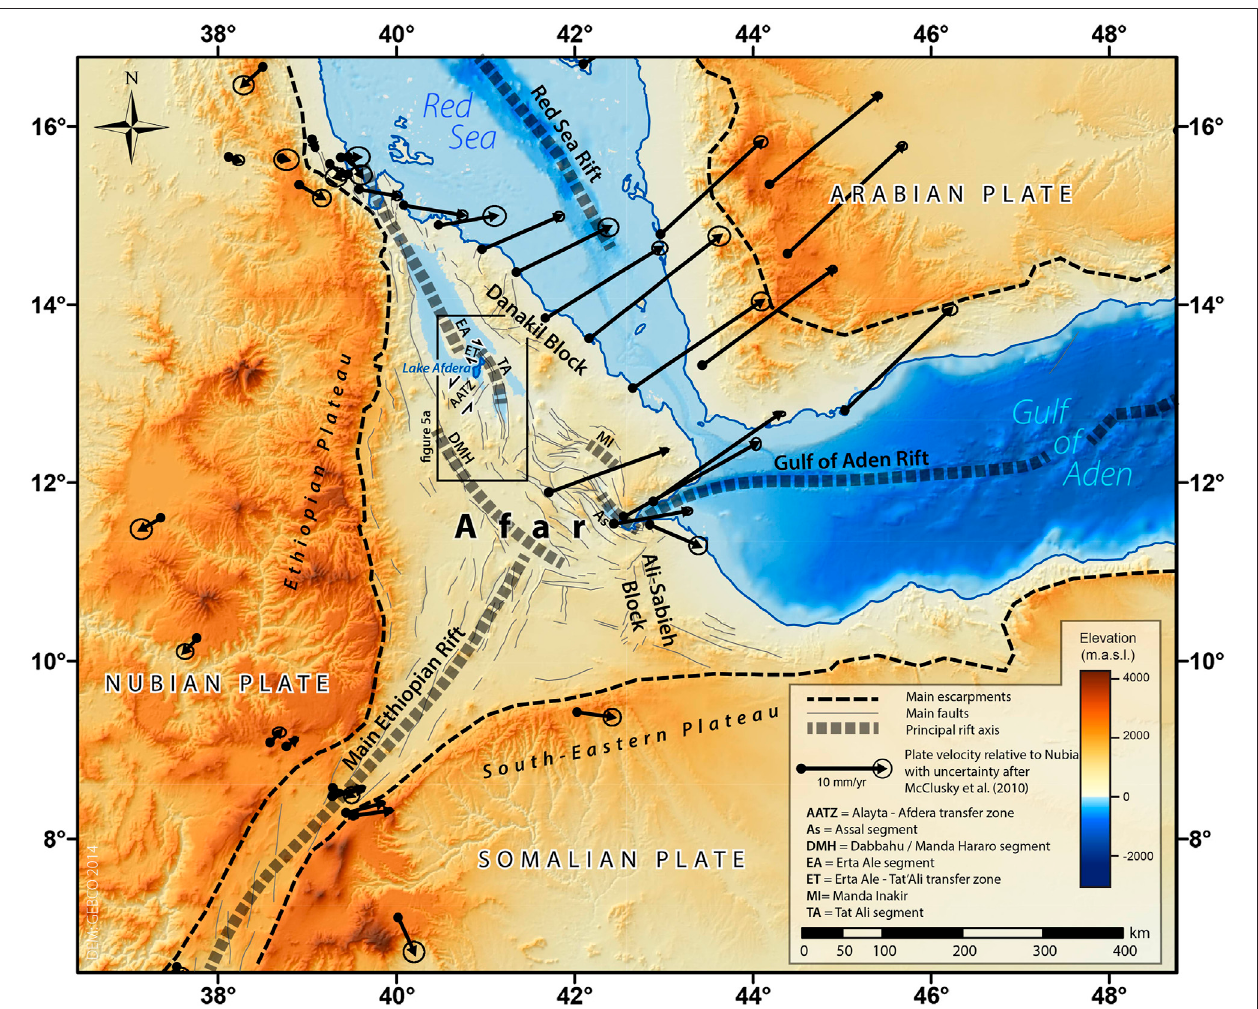
FIGURE1| ElevationmapoftheAfartriplejunction(EastAfrica),de fi nedbythedivergenceoftheArabian,NubianandSomalianplatesaswellasthepropagationof the Rea Sea, Gulf of Aden and Main Ethiopian Rifts. Black arrows show direction and velocity of the different plates (McClusky et al., 2010), relative to the Nubian plate. The black rectangle represents Figure 5A